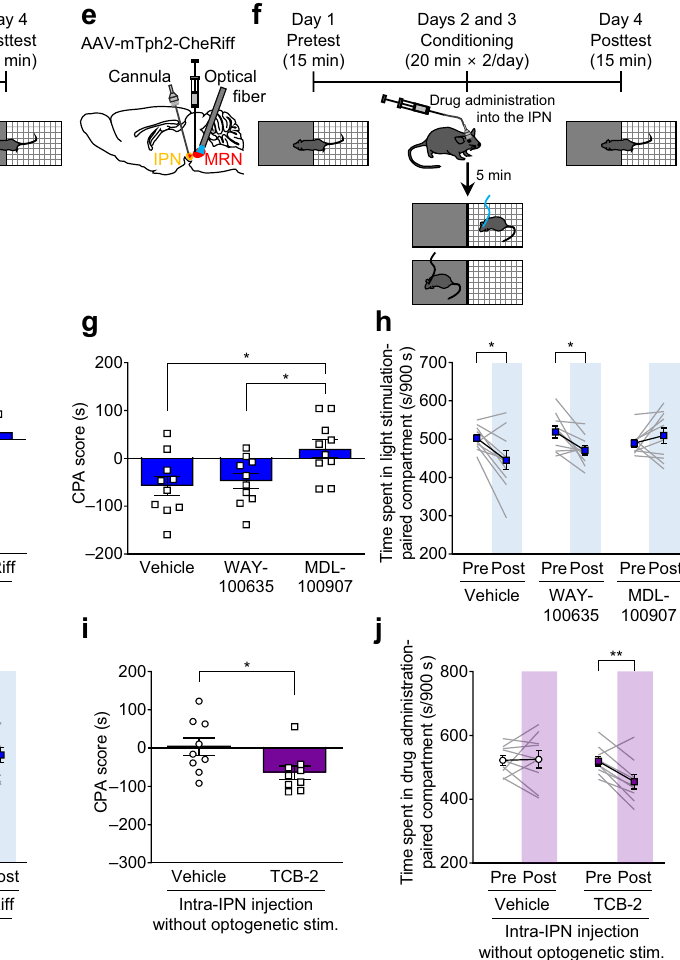
Fig. 8 | Effect with serotonin receptor antagonists on CPA induced by stimu- lation of MRN serotonergic neurons and effect with intra-IPN injection of 5-HT 2A receptor agonist on CPA. a , e Schematic representation of experiments. b CPA test with pretreatment with serotonin receptor antagonists (WAY-100635 (0.5mg/kg) or MDL-100907 (0.5mg/kg)) or vehicle (1% DMSO in saline). c CPA scores. Two-way ANOVA with Tukey post hoc test, virus×drug interaction F 2,47 =3.215,* P =0.0491,virus F 1,47 =2.539, P =0.1178,drug F 2,47 =4.907,* P =0.0116; post hoc test: Venus-Vehicle vs CheRiff-Vehicle * P =0.0465, CheRiff-Vehicle vs CheRiff-WAY-100635 * P =0.0401, CheRiff-Vehicle vs CheRiff-MDL-100907 ** P =0.0073. n =9 (except for Venus-MDL-100907) and 8 (Venus-MDL-100907)). d Spent time in the compartment associated with light. CheRiff-Vehicle: t 8 =3.959, ** P =0.0042, n =9 mice; CheRiff-WAY-100635: t 8 =0.3798, P =0.7140, n =9 mice; CheRiff-MDL-100907: t 8 =0.6239, P =0.5501, n =9 mice). f CPA test with intra-IPN injectionwithserotoninreceptorantagonists(WAY-100635(1 μ gin0.2 μ